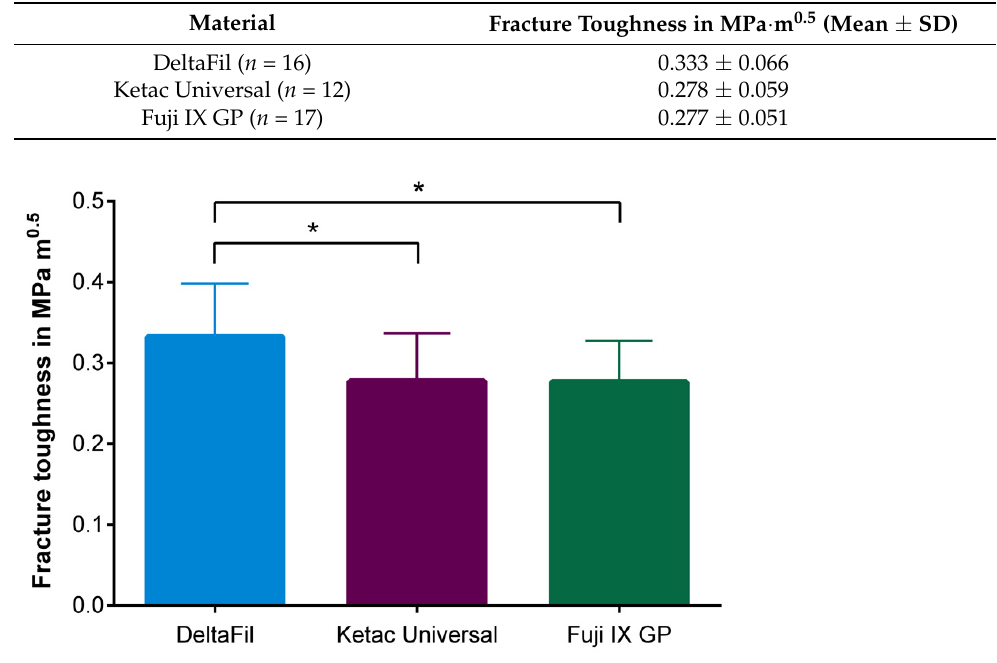
Figure 5. High resolution photographs showing the abraded surfaces of the restorations at termination of the chewing simulation. ( a ) DeltaFil (specimen 5; 1,200,000 cycles), ( b ) Ketac Universal (specimen 6; 668,629 cycles), ( c ) Fuji IX GP (specimen 5; 419,892 cycles). Red arrows indicate chipping and embrittlement of the restoration at the dentin interface. Table 3. Mean fracture toughness of the investigated GICs measured using a notchless triangular prism testing rig.